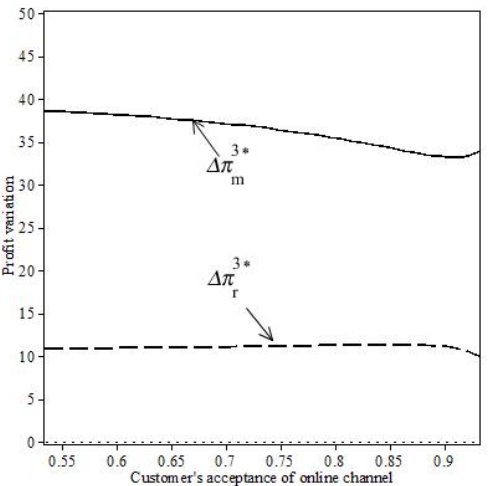
Figure 3. The impact of θ on the profit variation under Mechanism 3.